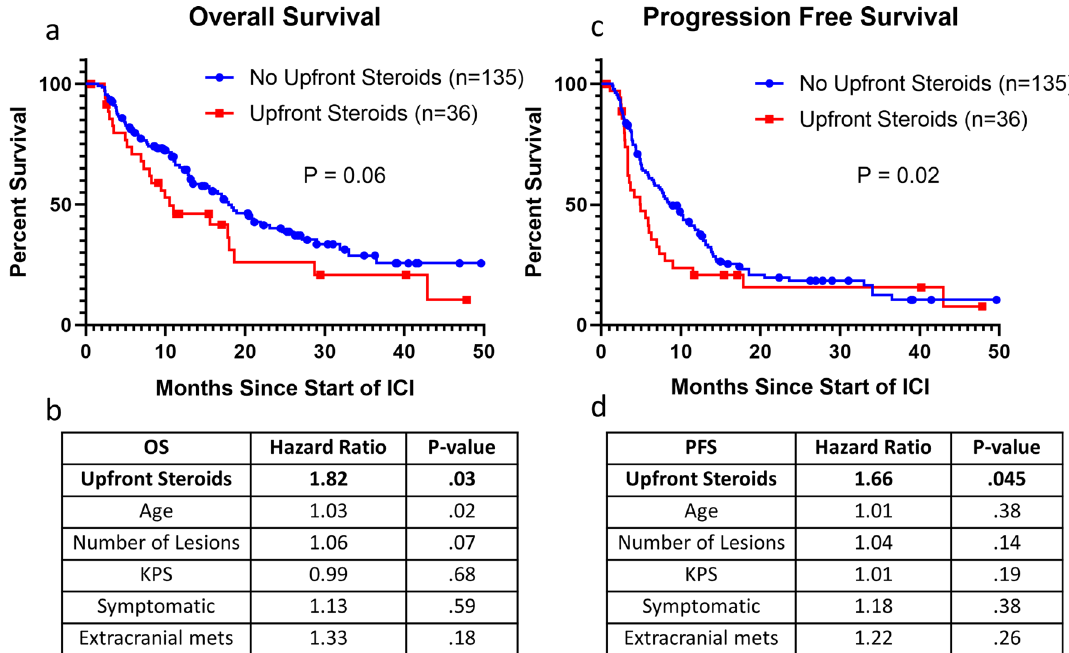
Figure 1. Upfront steroids decrease the efficacy of immune checkpoint inhibitors in NSCLCBM. ( a ) Overall Survival differences between those treated with or without upfront steroids. ( b ) Multivariable analysis of overall survival. ( c ) Progression-free survival differences between those treated with or without upfront steroids. ( d ) Multivariable analysis of progression-free survival. ( a ) and ( c ) group differences tested with the Wilcoxon test.